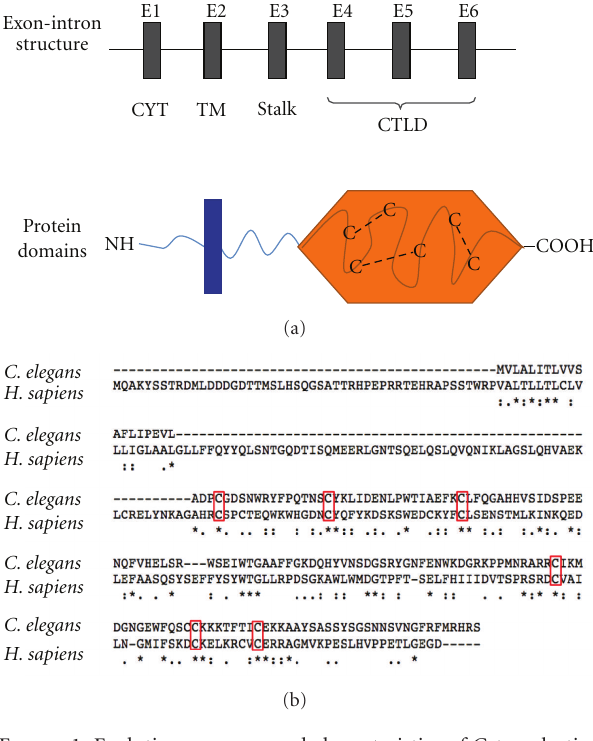
Figure 1: Evolutionary conserved characteristics of C-type lectin- like receptors. (a) Schematic representation of the common exon-intron structure of C-type lectin-like receptors and the corresponding protein domains. N-terminal cytoplasmic domain, transmembrane, and stalk region are each encoded by one exon, the C-type lectin-like domain (CTLD) by three exons. Disulfide bridged bonds between six highly conserved cysteins in the extracellular CTLD cause the typical β -sheet tertiary structure of C-type lectin- like proteins. (b) Alignment of human and putative C. elegans CLEC-1 protein sequences. Conserved CTLD cysteins are boxed in red, asterisk ( ∗ ) fully conserved, colon (:) strongly similar properties ( > 0.5 Gonnet PAM 250 matrix), period (.) weakly similar properties ( > 0.5 Gonnet PAM 250 matrix). Alignments were produced using ClustalW [26]. CYT: cytoplasmic region, TM: transmembrane region, CTLD: C-type lectin-like